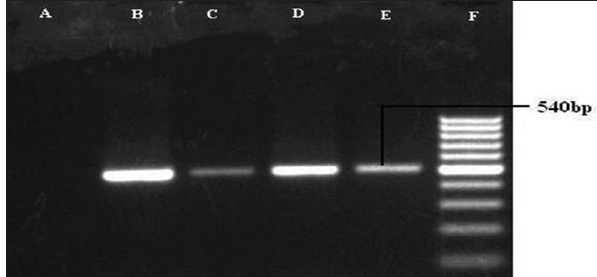
Figure-5: Polymerase chain reaction for the detection of hgbB gene (540 bp) of Pasteurella multocida. Lane A: Samples negative for hgbB gene. Lane B, C, D, and E: Samples positive for hgbB gene. Lane F: 100 bp DNA Ladder.